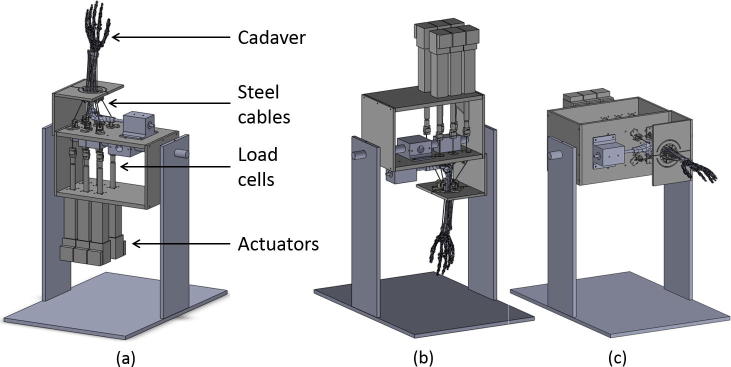
A schematic diagram of the wrist simulator with the hand in different orientations – (a) vertically upward (b) vertically downward (c) horizontal.